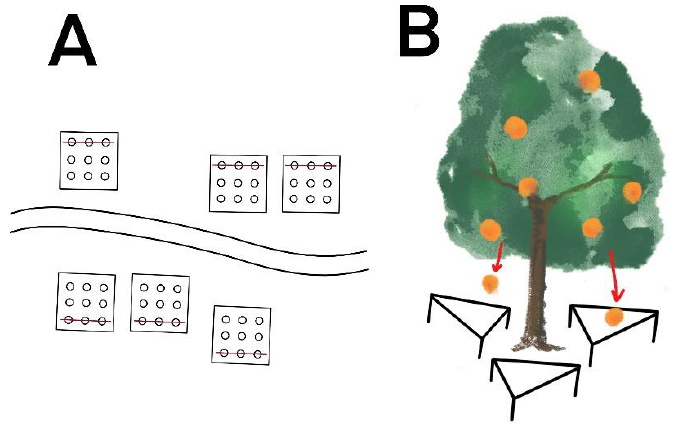
Figure 1. Survey citrus fruits cv. ‘Sai-Namphaung’ loss during preharvest ( A ) Six plots of three 5-year-old citrus trees were selected from each plot ( B ) and losses (i.e., dropping fruits) were gathered from nylon sheets laid underneath the tree canopy.